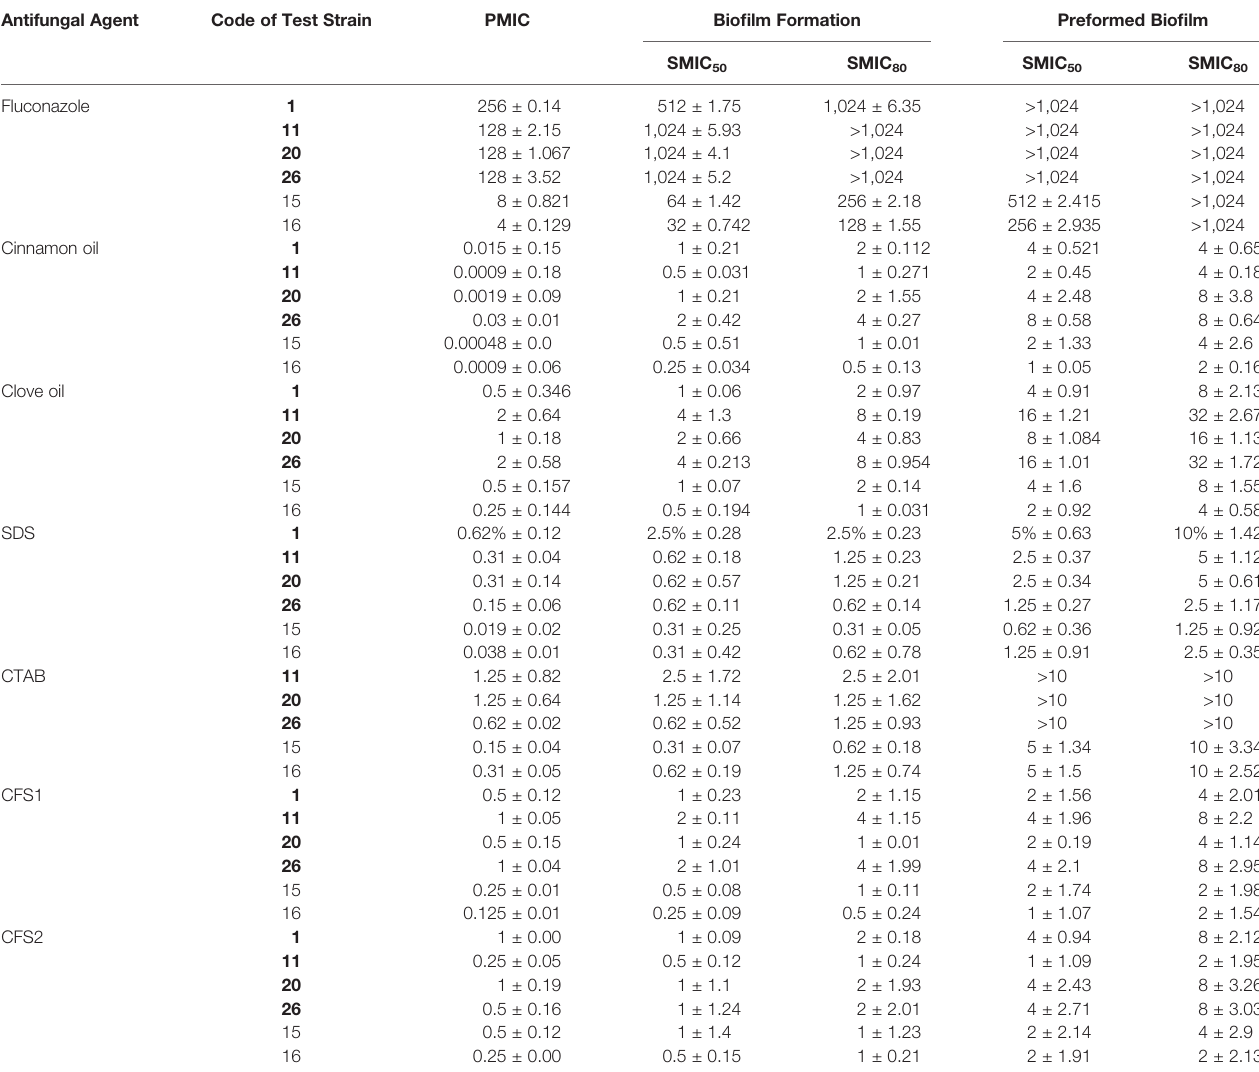
TABLE 2 | Minimum inhibitory concentration (µg/ml) values of different antifungals on planktonic C. albicans , bio fi lm formation, and preformed bio fi lm. Antifungal Agent Code of Test Strain